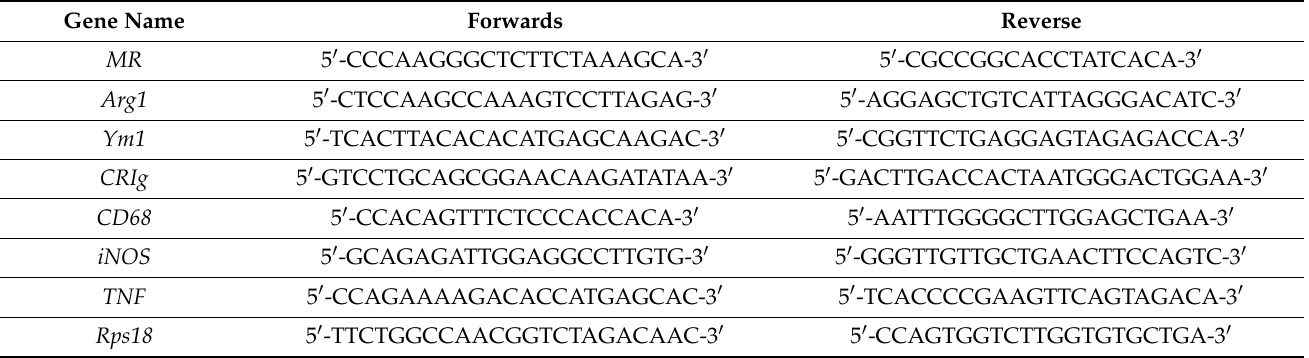
Table 1. The sequence of primers used on the